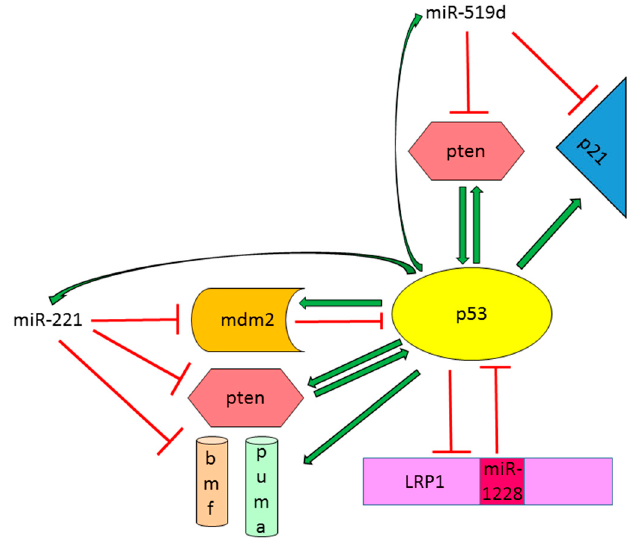
Figure 4. Regulation of p53 protein by oncogenic miRNAs in HCC. Green arrows: Induction of gene expression or protein activation. Red lines: Inhibition of gene expression or block protein activity.